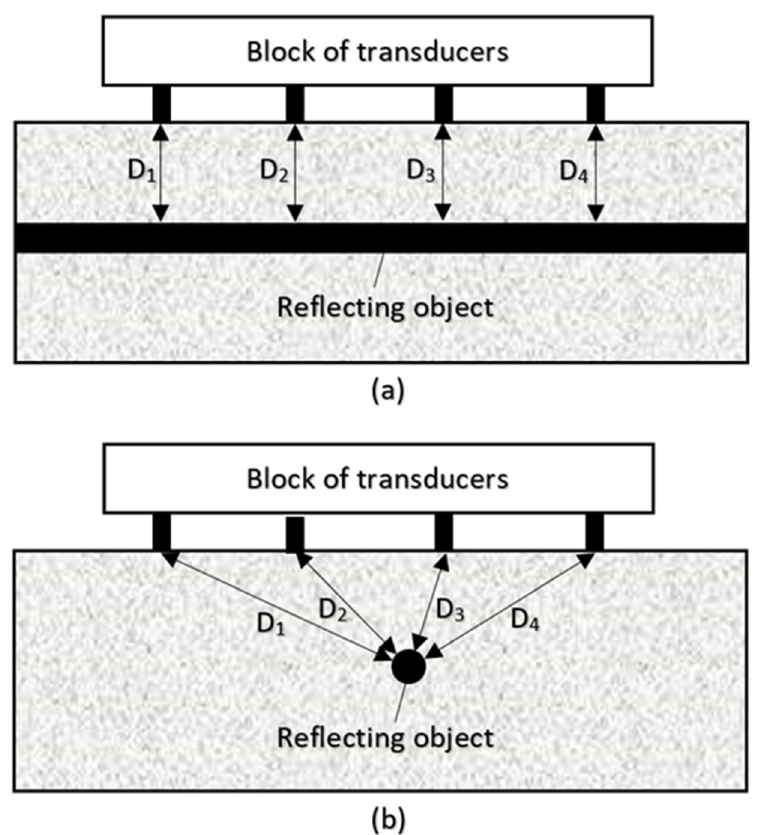
Figure 3. E ff ects of array polarization: ( a ) the re fl ecting object is parallel to the transducers and ( b ) Figure 3. Effects of array polarization: ( a ) the reflecting object is parallel to the transducers and ( b ) the point object or object perpendicular to the transducers. the point object or object perpendicular to the